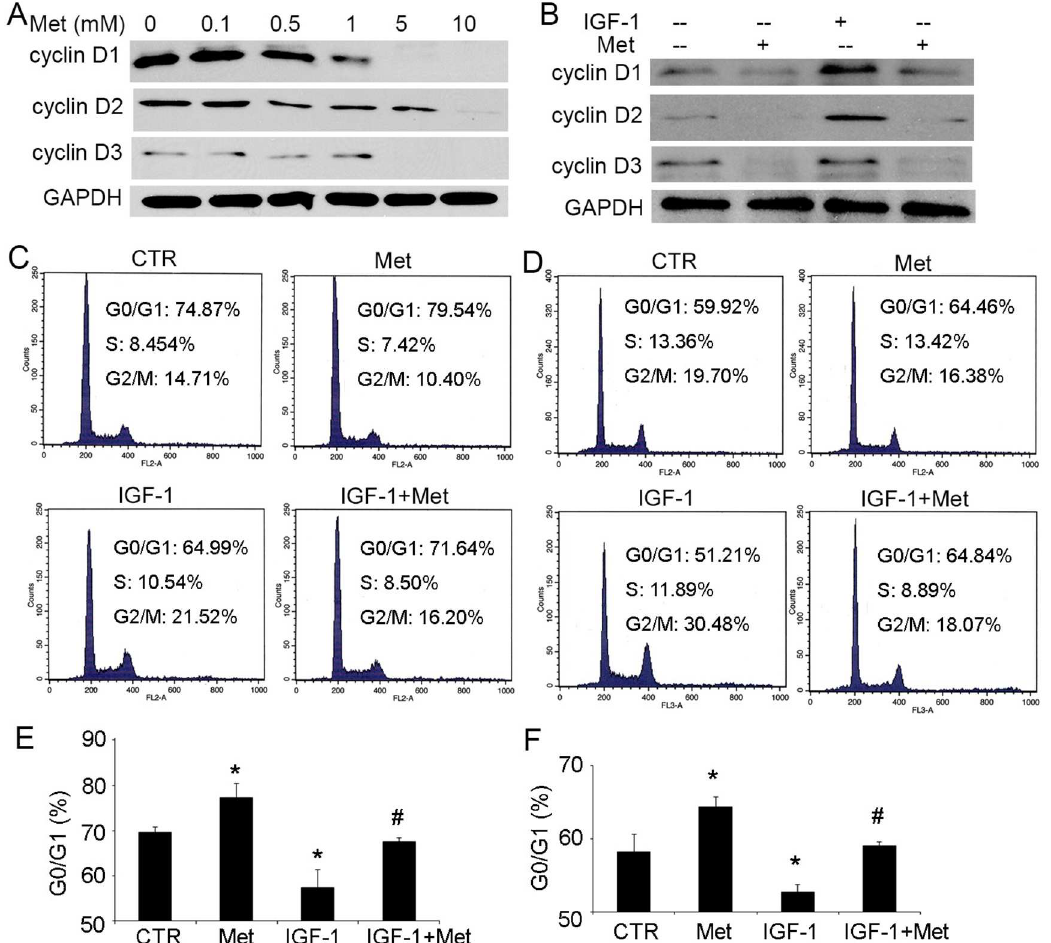
Fig 5. Metformin regulates cell cycle and the expression of proteins regulating cell cycle. A: Representative immunoblot analysisof cyclin D1, D2 and D3 in BPH-1 cells 48 hours after treatment of indicateddose of metformin. GAPDH was used as a loadingcontrol. B: The effect of 48-hour treatment of 100 ng/mL IGF-1 and 5 mM metformin on the expressionof cyclin D1, D2 and D3 in BPH-1 cells. C-D: Flow cytometry analysisof proliferating BPH-1 (C) and P69 (D) cells 48 hours after the addition of 100 ng/mL IGF-1, 5 mM metformin or both. E-F: The population of G0/G1 cells in BPH-1 (E) and P69 (F) cells (n = 3). * , P < 0.05compared with the control group; #, P < 0.05comparedwith the IGF-1 treated group. CTR: non-treatedcontrol, Met: